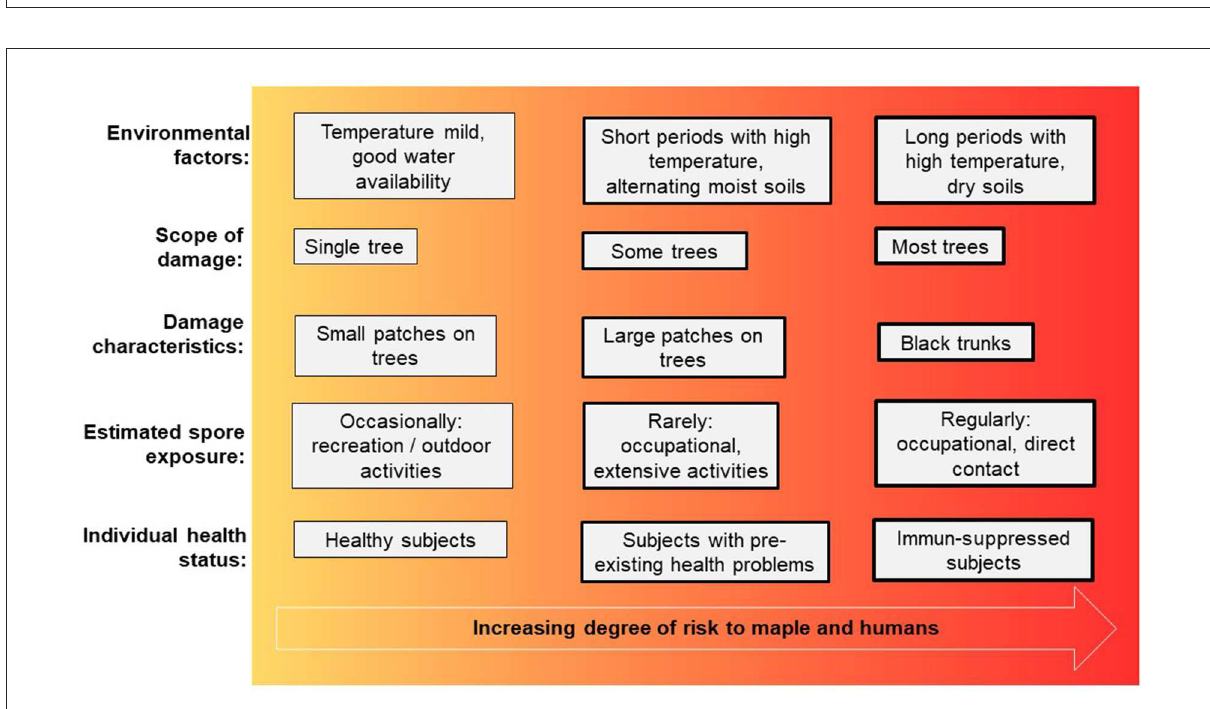
FIGURE3 Diagram of association between factors increasing the risk for sooty bark disease in maple and respiratory health problems in humans.